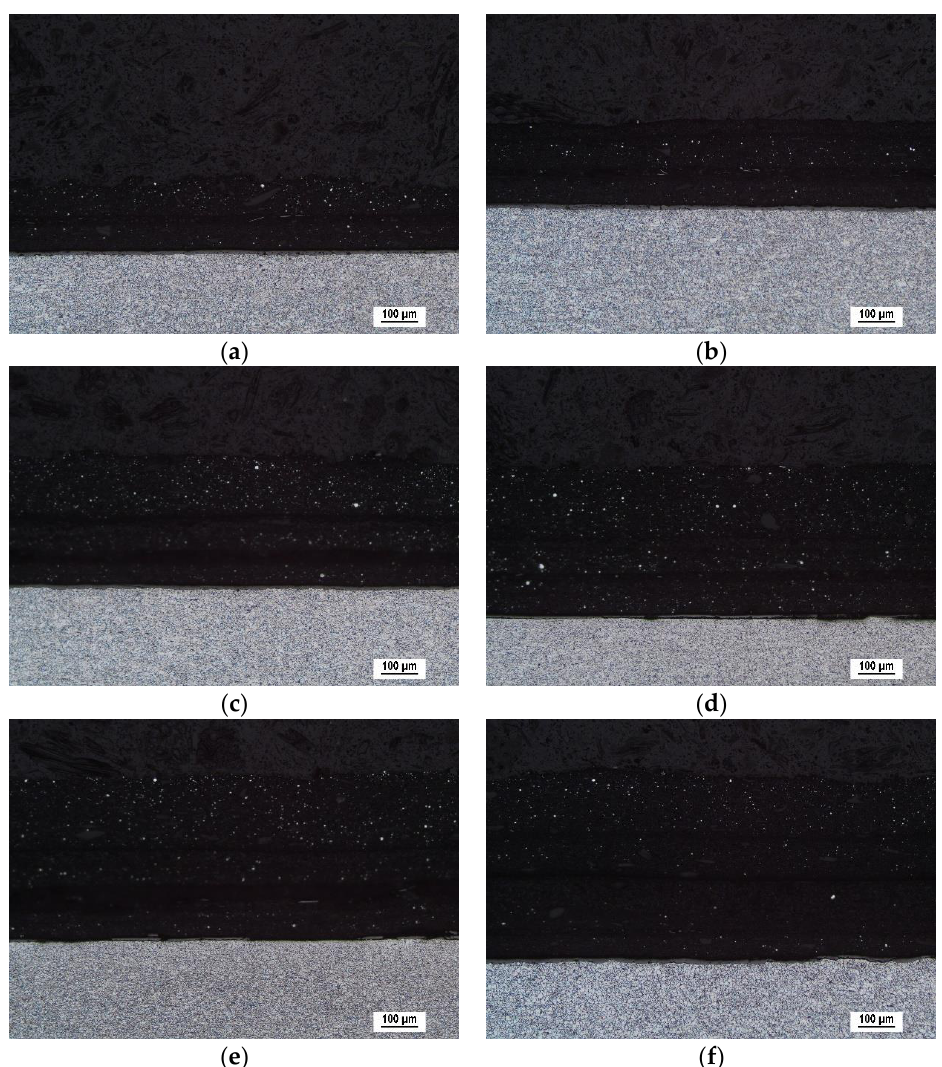
Figure 3. Metallographic images of coatings. ( a ) Coating thickness 171 ± 24 μm, ( b ) coating thickness 239 ± 10 μm, ( c ) coating thickness 389 ± 15 μm, ( d ) coating thickness 421 ± 25 μm, ( e ) coating thickness 444 ± 18 μm, and ( f ) coating thickness 517 ± 14 μm.